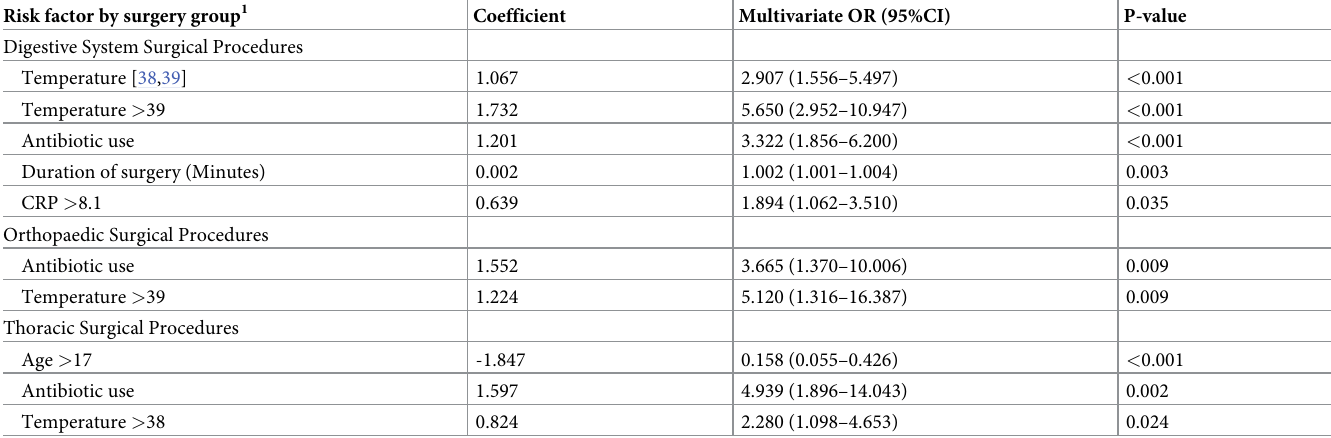
Table 4. Multivariate analysis risk factors for the occurrence of SSI by group of surgeries using data-driven cut-offs.